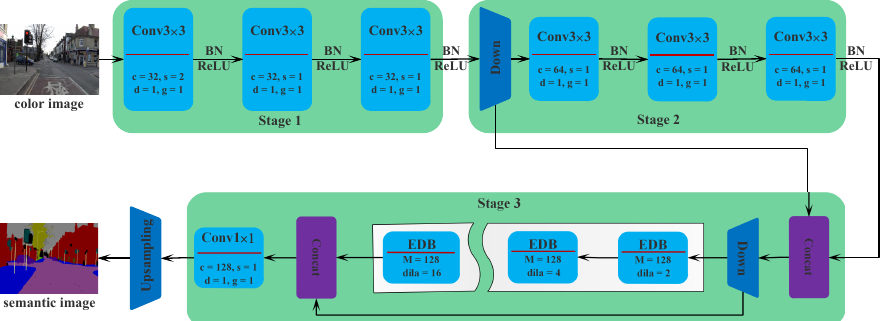
Figure 2. Structure of EDBNet. (c: Channel number; s: Convolution stride; d: Dilation rate; g: Group